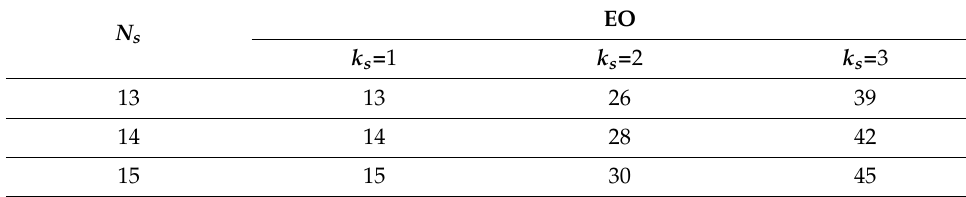
Table 3. Stator wake excitation frequency components with respective periods.